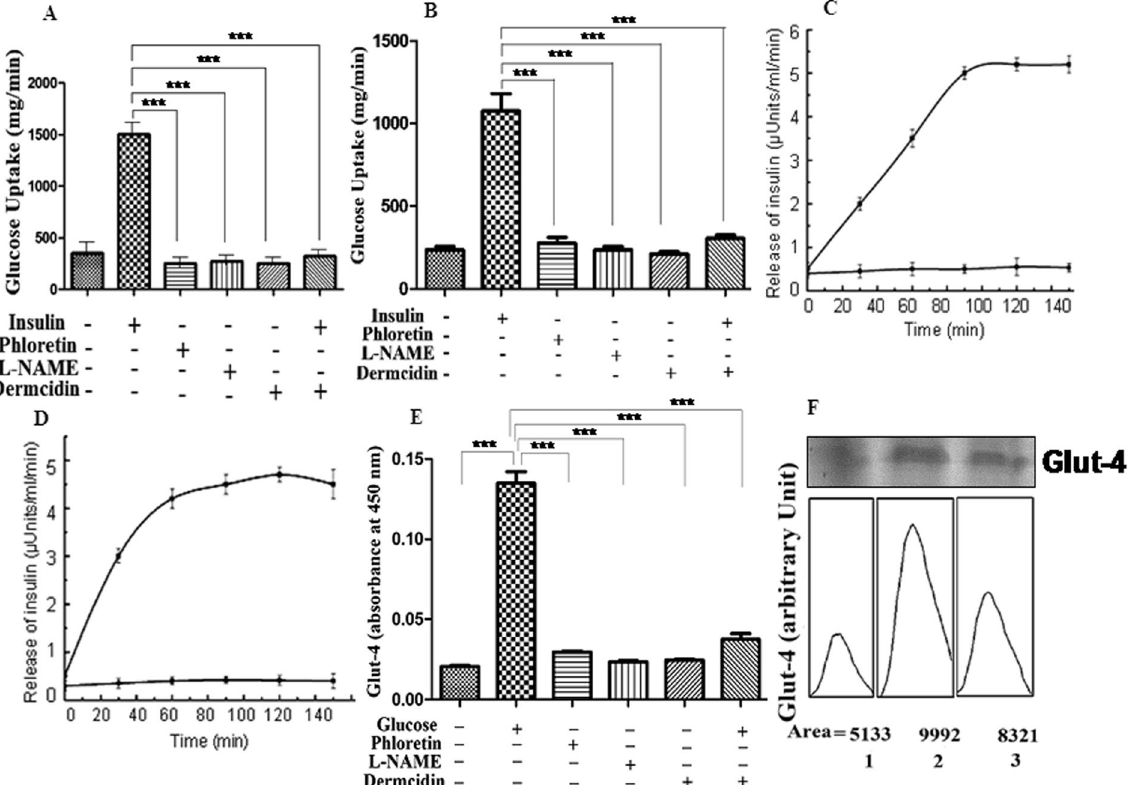
Figure 6. Role of dermcidin in glucose uptake, insulin release and glut-4 expression: Panel-A: The uptake of 2-deoxy-D 14 C glucose by insulin was measured in liver cell pretreated with either dermcidin, phloretin or L-NAME. Panel-B: The uptake of 2-deoxy-D 14 C glucose by insulin was measured in pancreatic β -cell pretreated with dermcidin, phloretin or L-NAME. Panel-C: Release of insulin from liver cells in the presence and absence of dermcidin. Solid squares ( ■ ) = insulin release in the absence of DCN-2, solid circles ( ● ) = insulin release in the presence of DCN-2. Panel-D: Release of insulin from pancreatic β -cells in the presence and absence of dermcidin. Solid squares ( ■ ) = insulin release in the absence of DCN-2, solid circles ( ● ) = insulin release in the presence of DCN-2. Panel-E: Glut-4 synthesis in liver cells in presence of glucose, dermcidin, phloretin or L-NAME. Panel-F: Immunoblot of Glut-4 in liver cells treated with dermcidin and in the presence and absence of glucose and the integrated area of each of the Glut-4 immunopositive band. Data are mean ± S.D. of at least 5 different experiments using 5 different animals each in triplicate ( *** represents p <